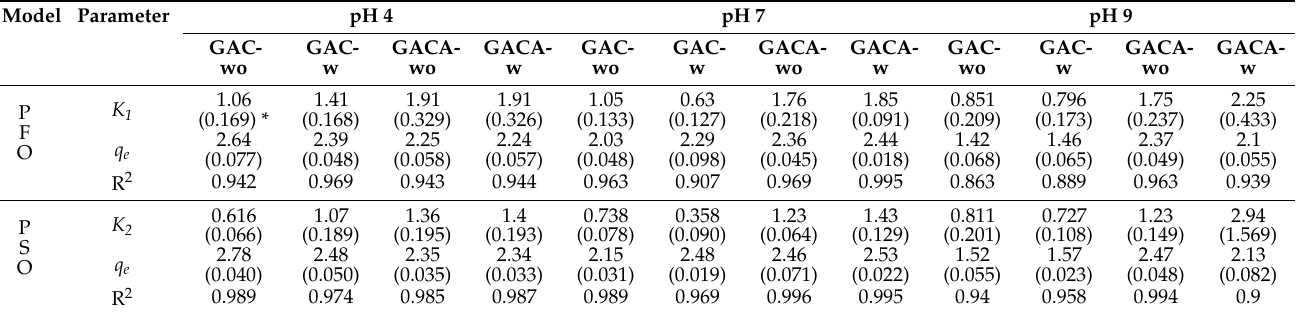
* indicate stand error using SigmaPlot